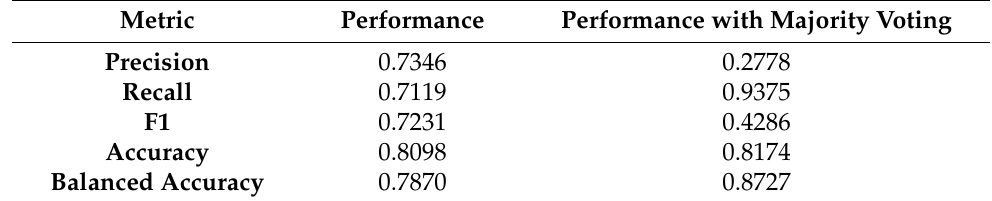
Table 7. The ODG image classification model performance without and with majority